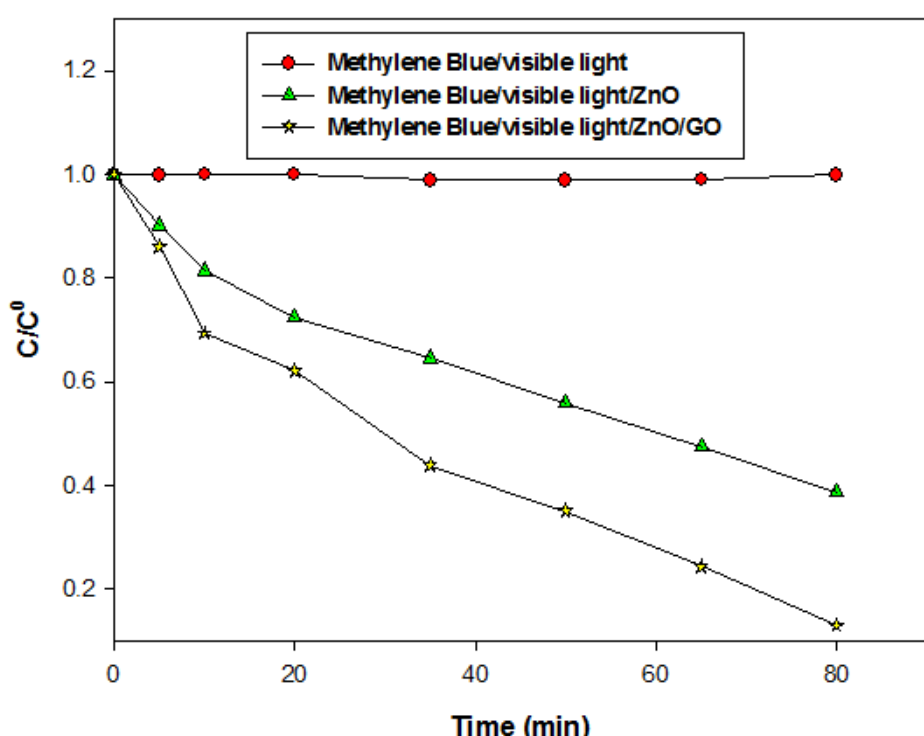
Figure 9. Observation of changes in methylene blue concentration with time following irradiation in the absence and presence of ZnO and ZnO/GO.